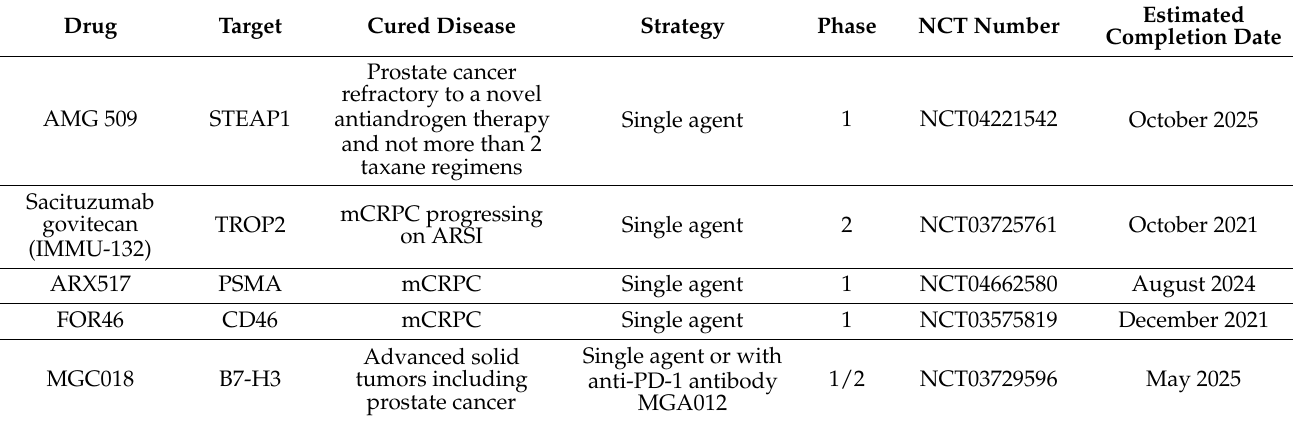
Table 3. The clinical trial data of antibody–drug conjugates in prostate